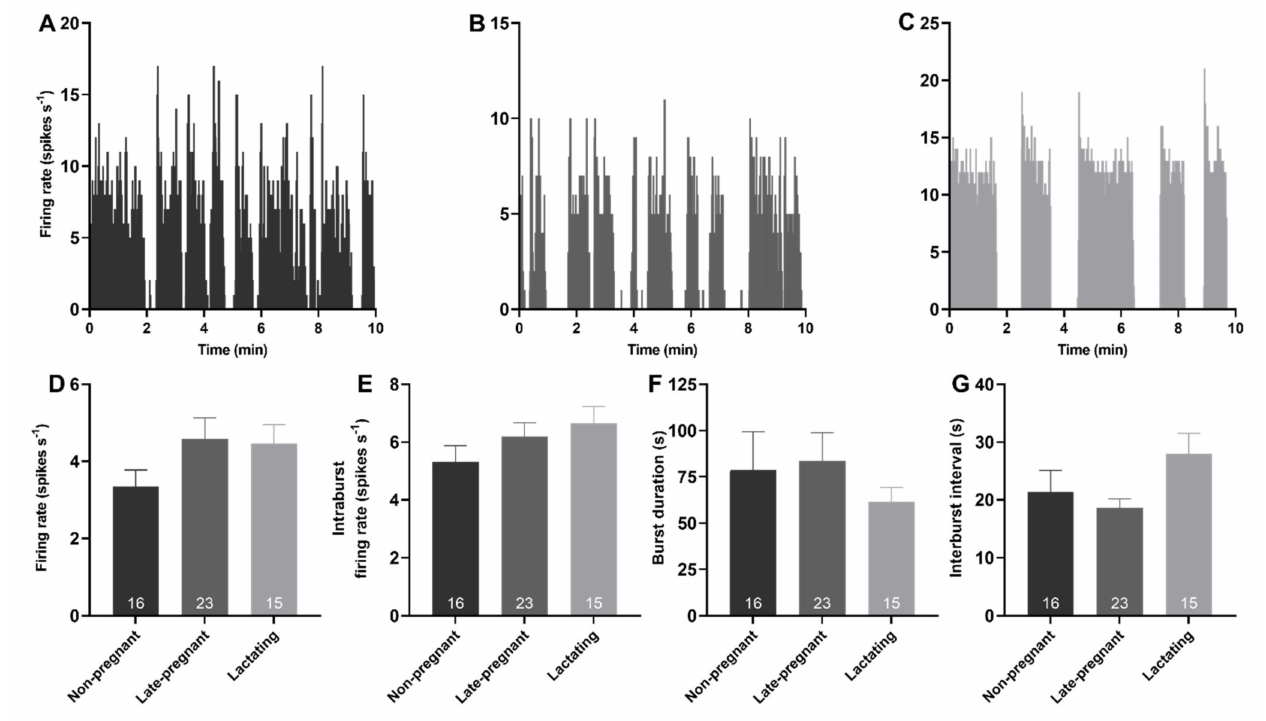
Figure 2. Phasic activity of vasopressin neurons was not affected by reproductive status. ( A – C ). Example ratemeter recordings of spontaneous phasic activity in vasopressin neurons (in 1 s bins) from urethane-anaesthetised non-pregnant ( A ), late-pregnant ( B ), and lactating ( C ) rats. ( D – G ). Mean ( ± SEM) phasic neuron firing rate ( D ), intraburst firing rate ( E ), burst duration ( F ), and interburst interval ( G ) in non-pregnant, late-pregnant, and lactating rats. There was no effect of reproductive status on the firing rate ( H = 3.52, p = 0.17), intraburst firing rate ( H = 2.31, p = 0.32), burst duration ( H = 0.26, p = 0.88), or interburst interval of phasic neurons ( H = 4.72, p =